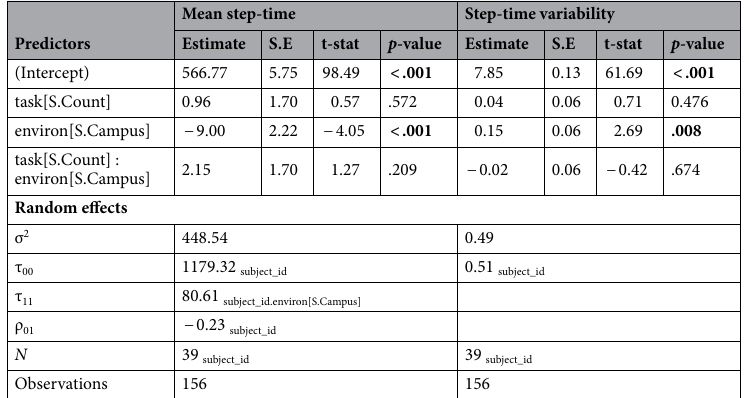
Table 4. Summary of linear mixed-effects models for gait parameters. Note Factor variables sum-to-zero contrast-coded. Estimate = beta coefficient, S.E. = standard error, task = cognitive task condition (Count, Ignore), environ = environmental context (Field, Campus), σ 2 = residual variance, τ 00 = random intercept variance, τ 11 = random slope variance, ρ 01 = random effect correlation coefficient, N = number of levels per grouping variable. Bold p-values indicate significance at an alpha threshold = .05.